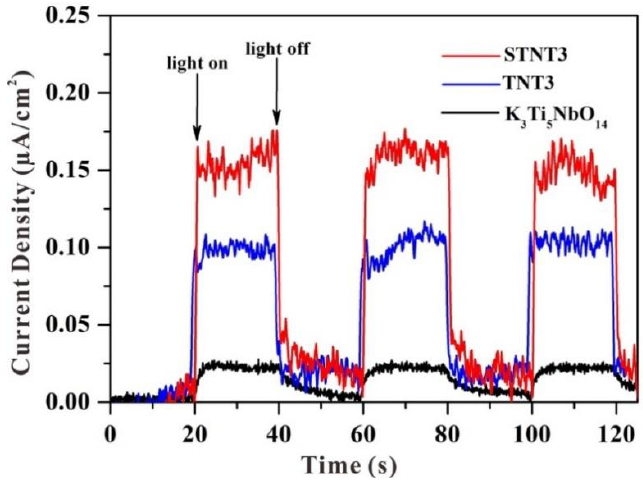
Figure 8. Transient photocurrent responses of different samples under simulated solar light irradiation.